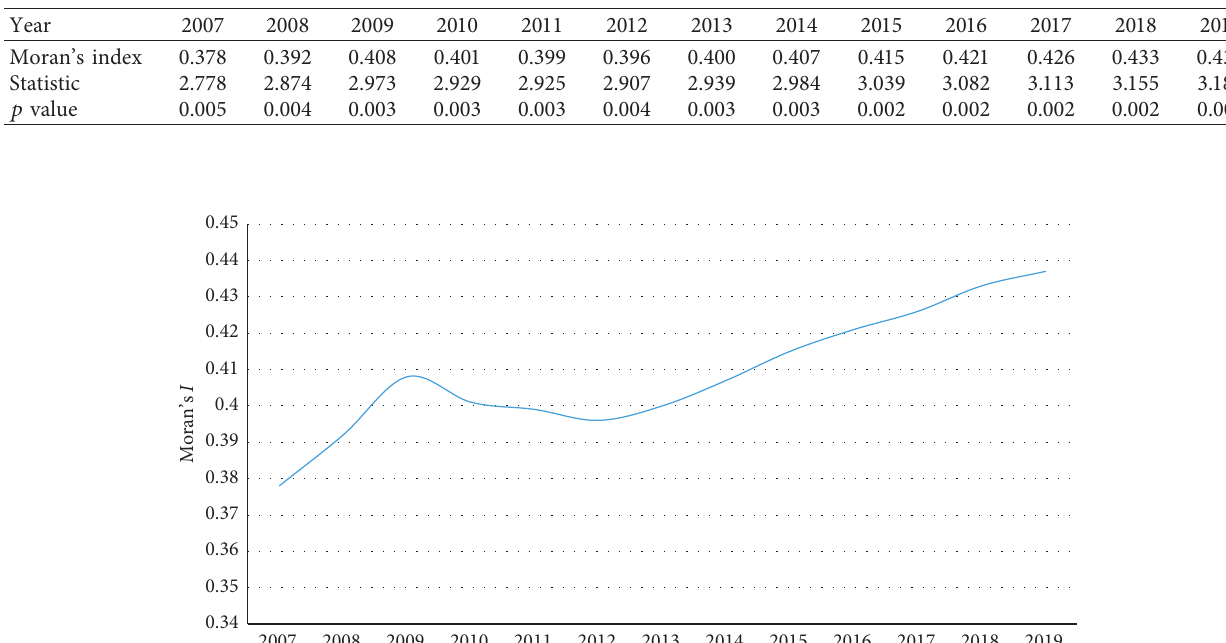
Table 3: Global Moran’s index.